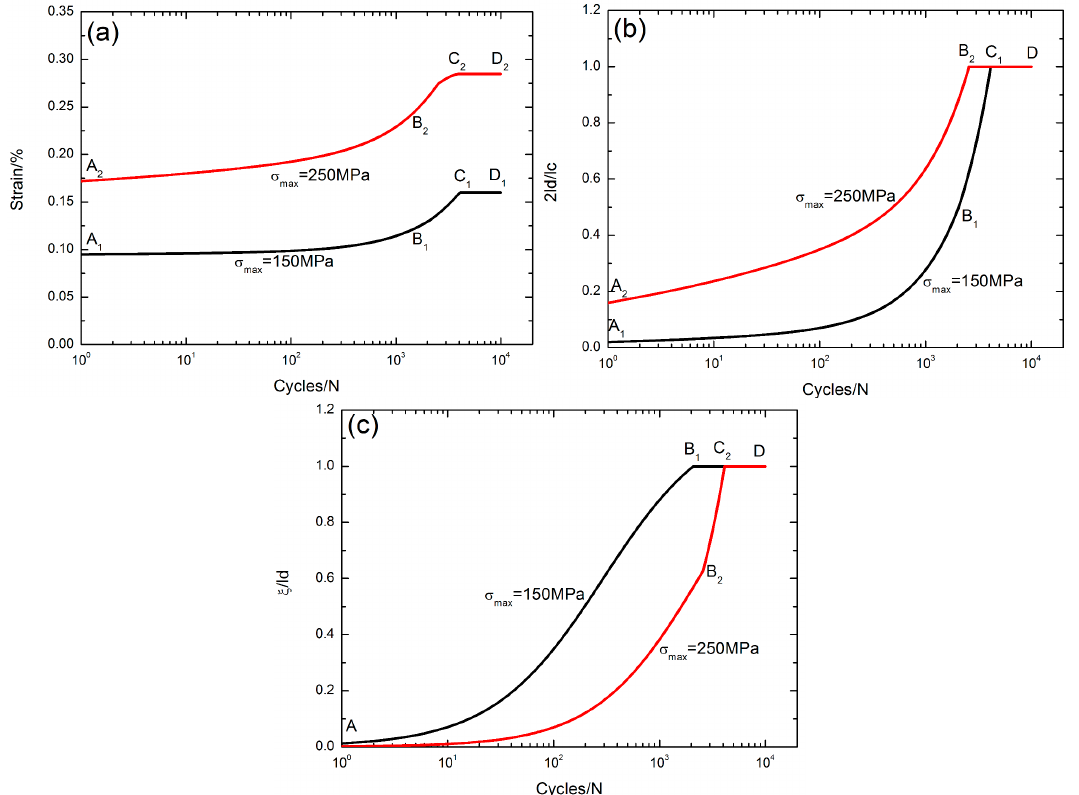
Figure 7. ( a ) The peak strain versus cycle number curves; ( b ) the interface debonded length 2 l d / l c versus cycle number curves; and ( c ) the interface oxidation length ξ / l d versus cycle number curves under fatigue peak stresses of σ max = 150 and 250 MPa with stress rupture time t = 10 s at the oxidation temperature of Tem = 800 °C.